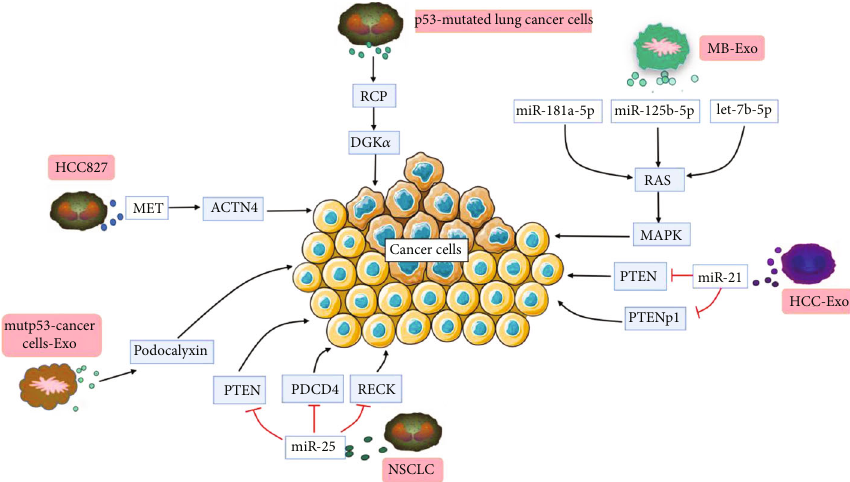
Figure 1: CSC-Exos are involved in cancer cell proliferation. Exosomes secreted from p53-mutated lung cancer cells promote cancer cells proliferation by mediating the RCP/DGK α receptor cycling pathway. The production of cancer stem cell-derived exosomes (CSC-Exos) induced by mutated TP53, and these CSC-Exos can regulate the expression levels of podocalyxin and promote cancer cell growth. Hepatocellular carcinoma (HCC) cell-derived exosomes carrying miR-21 promote the proliferation of HCC cells by inhibiting the expression of PTENp1 and PTEN. Exosomes derived from non-small-cell lung cancer (NSCLC) cells carry miR-25 to reduce the expression of the PTEN, PDCD4, and RECK in NSCLC cells, leading to the growth of cancer cells. Medulloblastoma-derived exosomal miRNAs such as miR-181a-5p, miR-125b-5p, and let-7b-5p promote the proliferation of cancer cells via the Ras/MAPK pathway. Medulloblastoma (MB) cell-derived exosomal miRNAs such as miR-181a-5p, miR-125b-5p, and let-7b-5p promote the proliferation and invasion of cancer cells via the Ras/MAPK pathway. Icotinib-resistant human NSCLC (HCC827) cells produce exosomes carrying oncogenic MET mRNAs that mediate NSCLC progression by upregulating alpha-actinin 4 (ACTN4).